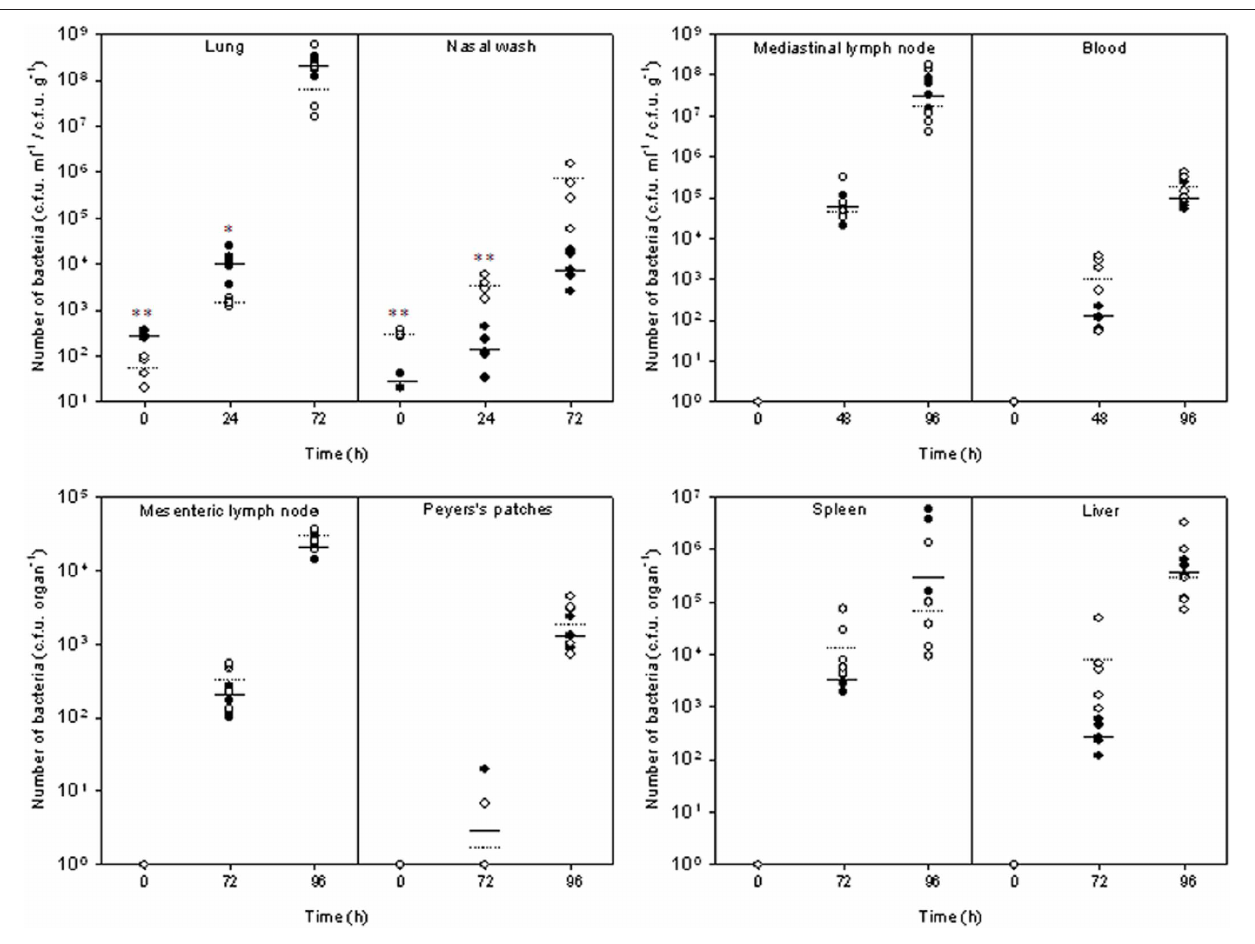
FIGURE 2 | Bacteriological kinetics within tissues of Balb/c mice exposed to aerosols of different particle sizes containing Burkholderia pseudomallei K96243. • , Small particle (1 μ m) infection generated by the Collison nebuliser; ◦ , large particle (12 μ m) infection generated by the FFAG.